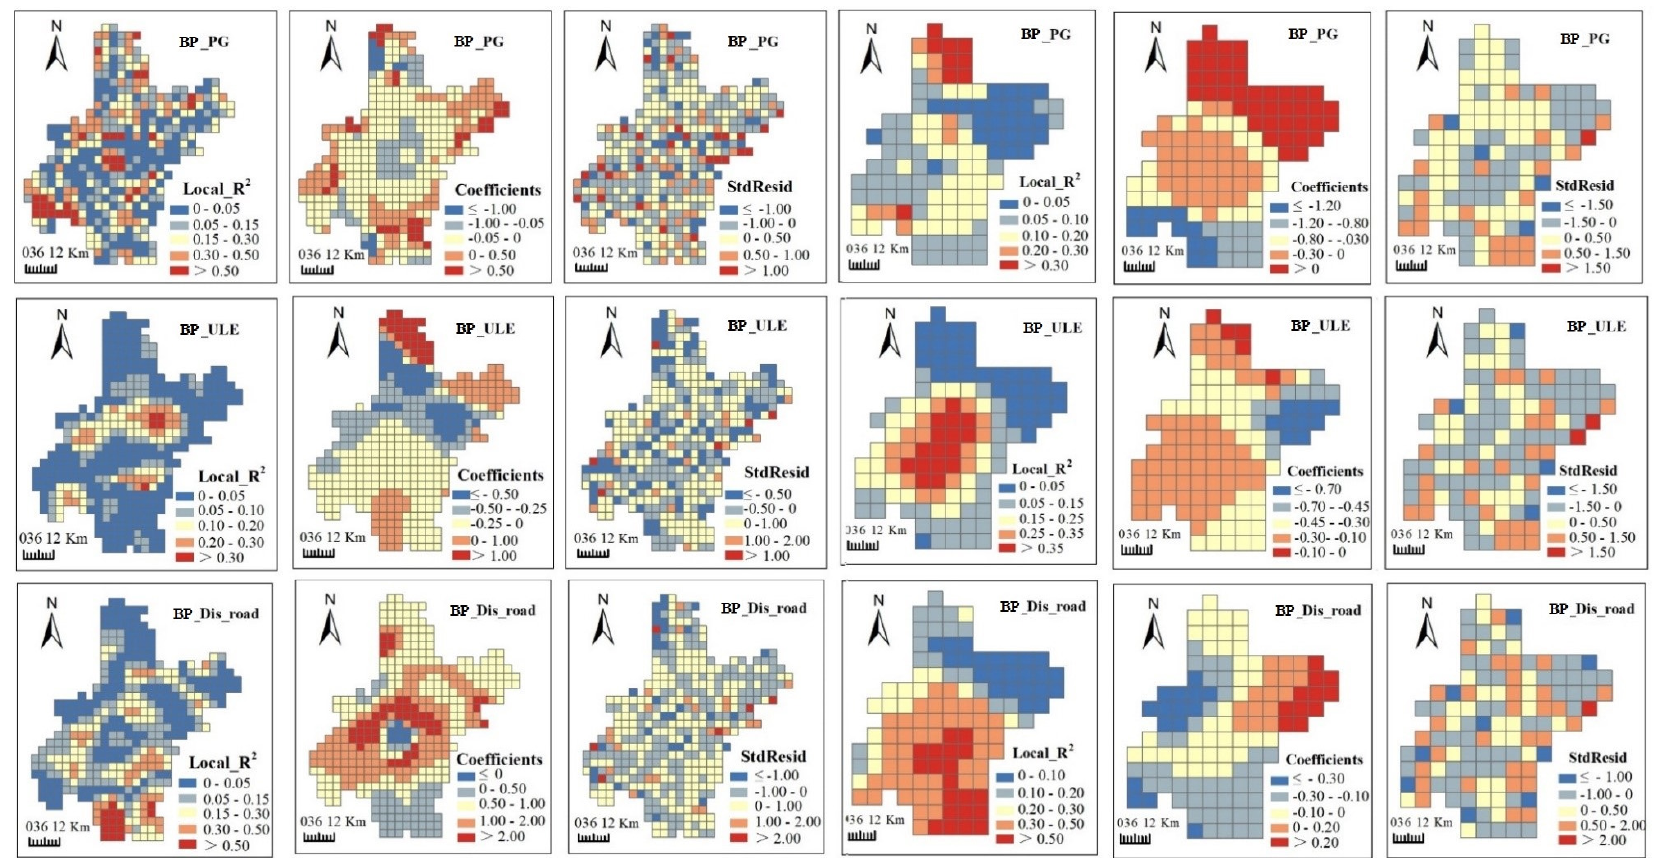
Figure 8. Spatial patterns of local R 2 , coefficients and standard residuals (StdResid) from geographically weighted regressions (GWRs) between Biodiversity potential (BP) and urbanization indicators at 5 km ( left three columns ) and 10 km ( right three columns ) grid scales. Abbreviations: Population growth (PG); Urban land expansion (ULE); Distance to major roads (Dis_road).